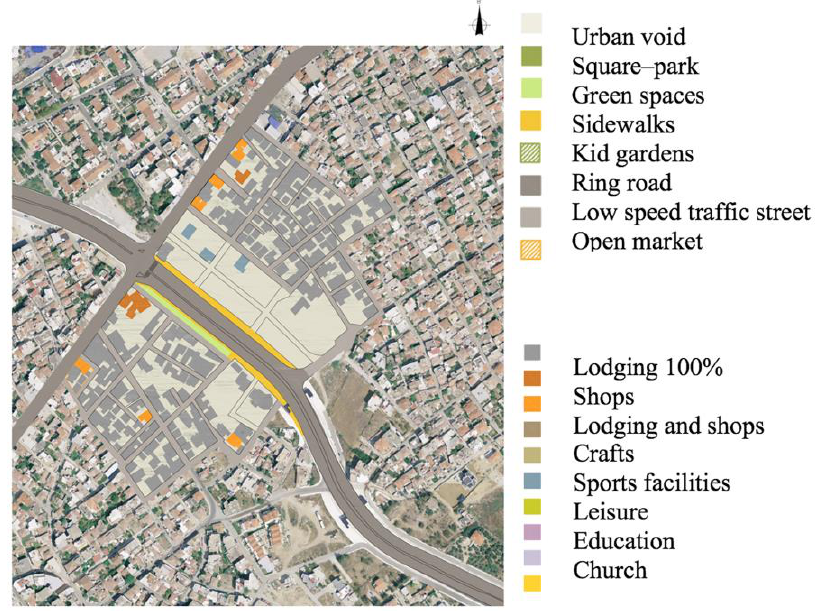
Figure 15. Map of predominant uses in Iolkos UA, Volos.